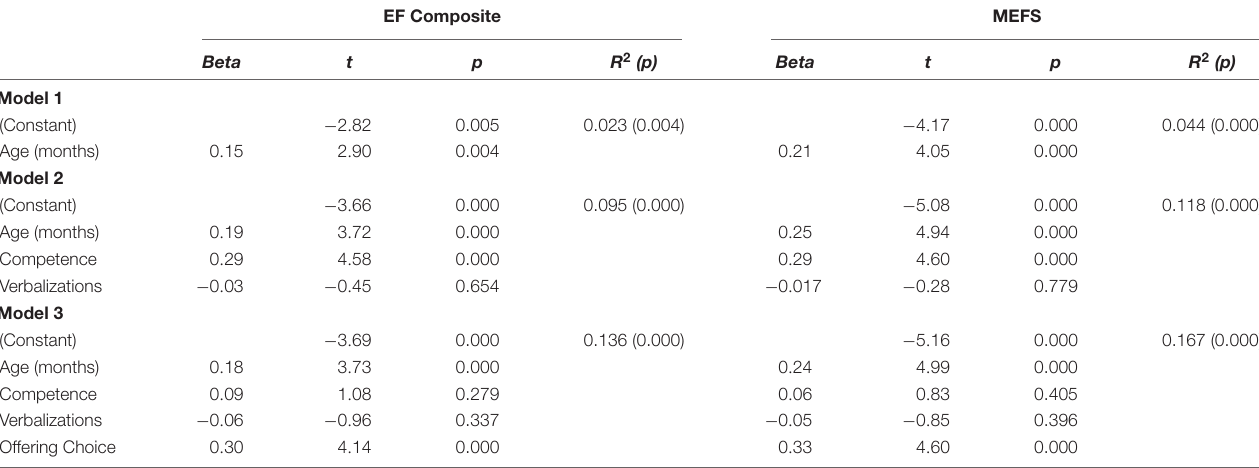
TABLE 3 | Hierarchical regression analyses of autonomy support subscales predicting child